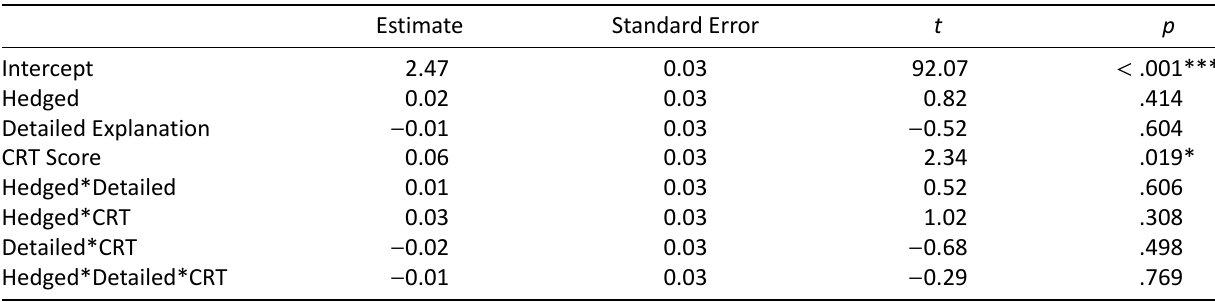
Table 5. General linear model predicting resistance of information from correction style conditions and CRT as potential